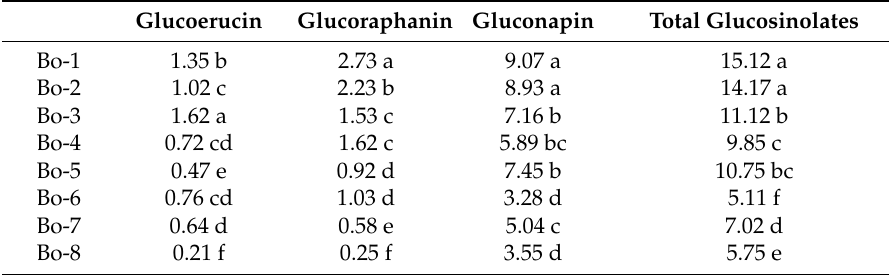
Table 1. Glucosinolate composition and content (µmol·g − 1 DW) in Chinese kale bolting stems of different varieties.